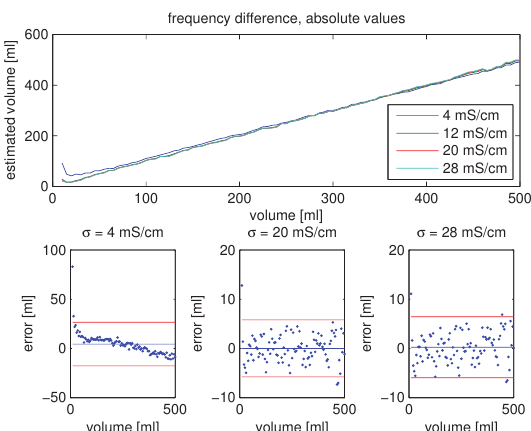
Fig.10: In-silico results for frequency-differential variant using absolute values: Comparable result to the single-frequency variant using imaginary parts.